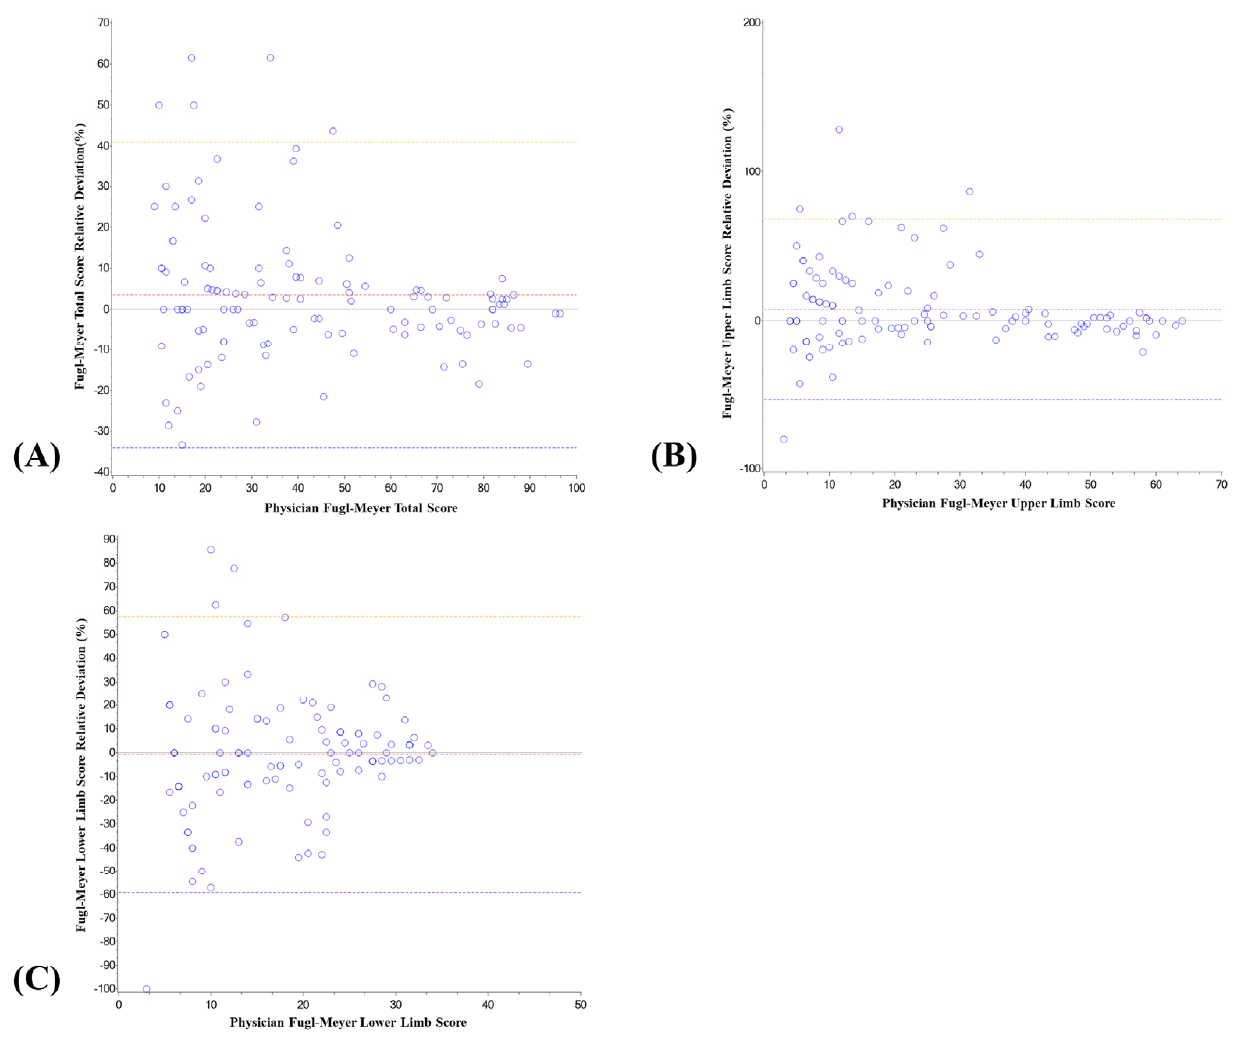
Figure 7. Intelligent rehabilitation system score and physician’s FMA score relative deviation analysis chart. Total score ( A ), upper − limb score ( B ), and lower − limb score ( C ) are the results of relative deviation between intelligent rehabilitation system score and physician’s FMA score.